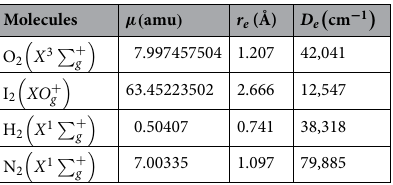
Table 1. Model parameters used for diatomic molecules 25 .